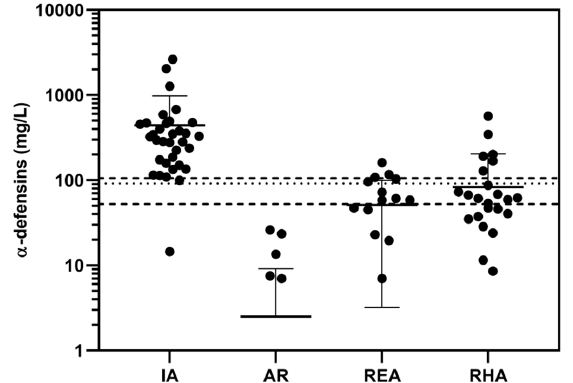
Figure 3. Synovial fluid α -defensins concentrations (logarithmic scale) for the patients with infectious arthritis (IA) versus patients with aseptic diseases: arthrosis (AR), reactive arthritis (REA), and rheumatoid arthritis (RHA). The cutoff concentration (98 mg/mL) is represented by the dotted line. The two broken lines enclose what can be termed a “gray zone” within the range 63–108 mg/L. The lower broken line also indicates the cutoff concentration (62.5 mg/mL) in the case of comparison of IA, but only against AR. Table 1. Synovial fluid examination for α -defensins (HNP1–3) by HPLC, microbial culture cultivation, and PCR, in patients with orthopedic diseases of infectious and noninfectious origin. Patient Cultivation PCR AD by HPLC Diagnosis